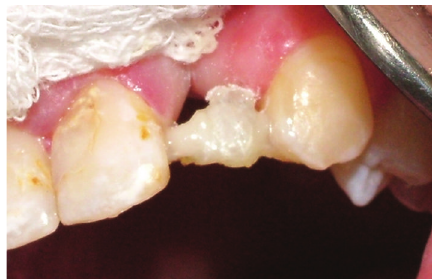
Figure 7: Fiber-reinforced composite.